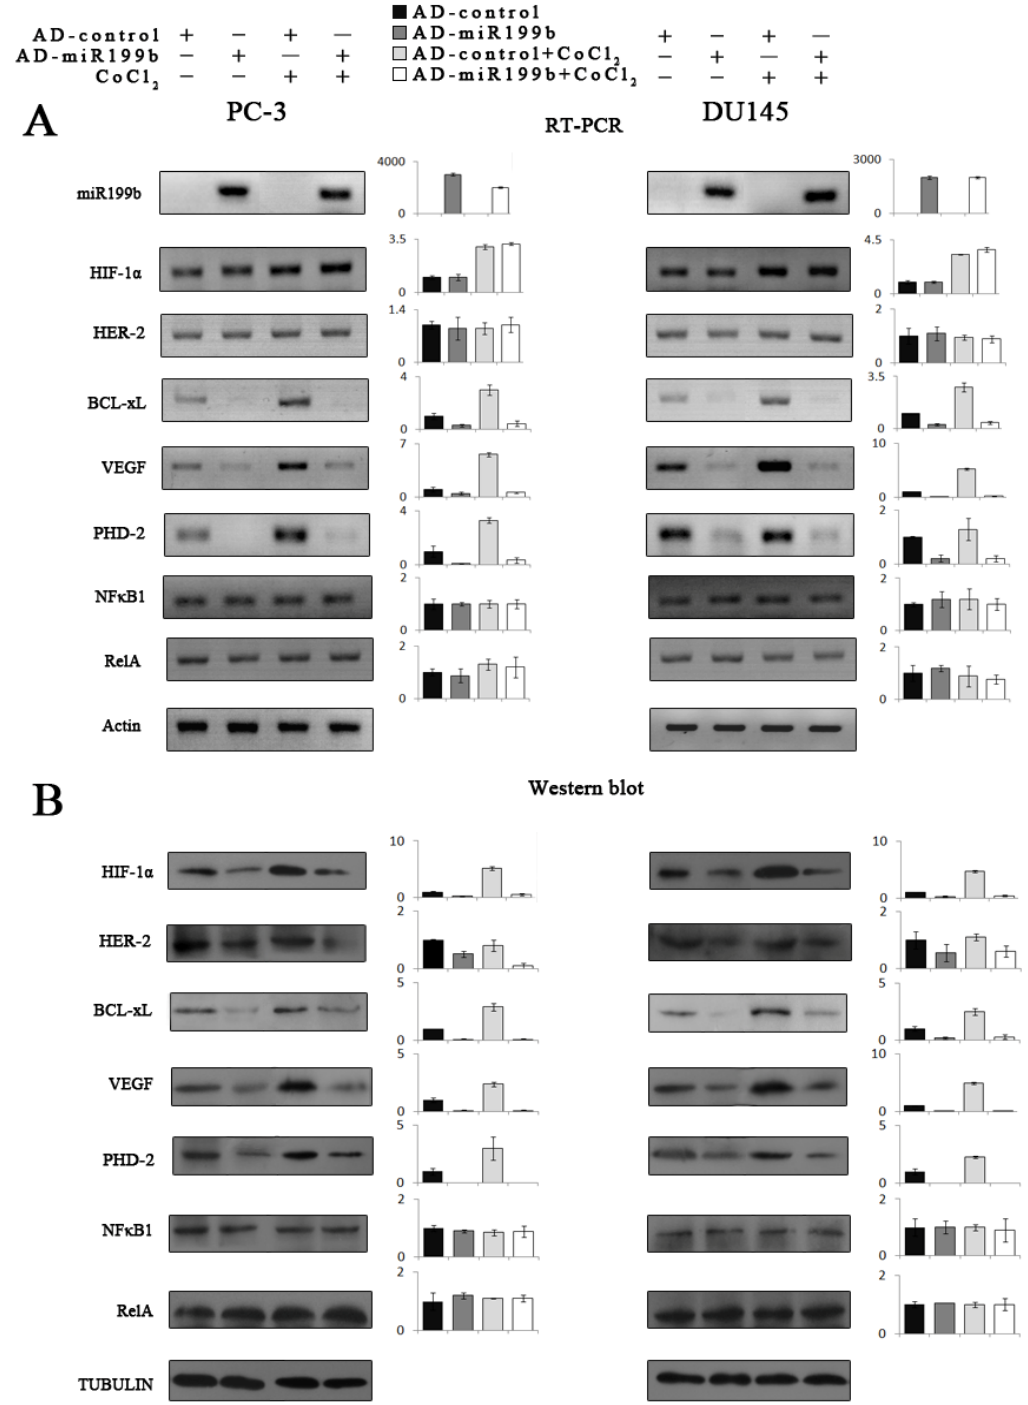
Figure 3. Effects on HIF-1 α and its targets by artificial overexpression of miR199b in prostate cancer cells under normoxic and hypoxia-mimicking conditions. Artificial overexpression of miR199b by Ad-miR199b ( A , top) resulted in the significant downregulation of HIF-1 α protein level compared with Ad-control ( B , Western blot with semiquantitative histograms) but no change in the HIF-1 α mRNA or NF κ B mRNA ( A ) or protein ( B ) levels ( A , left, RT-PCR; right, Q-PCR). HIF-1 α target genes BCL-xL, VEGF and PHD-2 were simultaneously deregulated upon miR199b overexpression ( A ) and HIF-1 α downregulation ( B